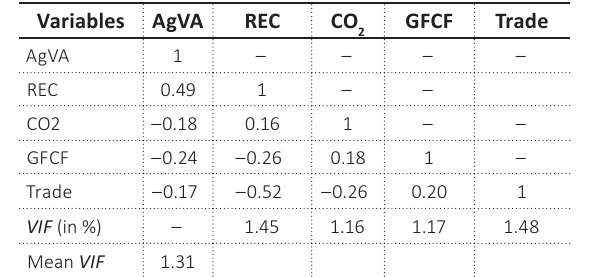
Table 2. Correlation between variables and